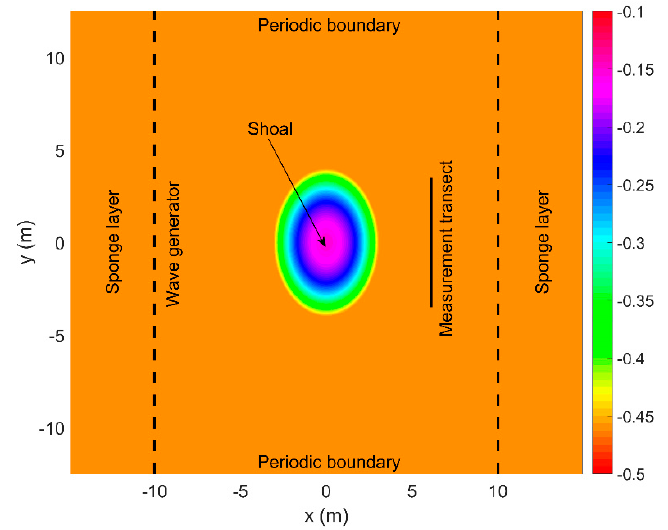
Figure 12. Bottom levels of the experimental setup used by Vincent and Briggs, as it is implemented in the numerical domain in MILDwave.